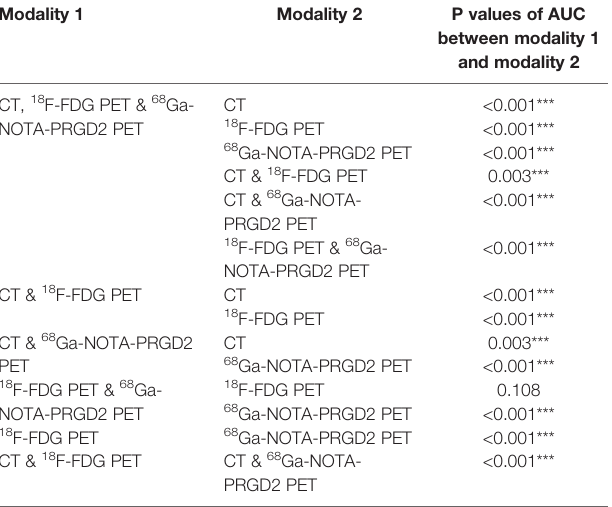
TABLE 4 | Signi fi cance test of differences in AUC values of different models.